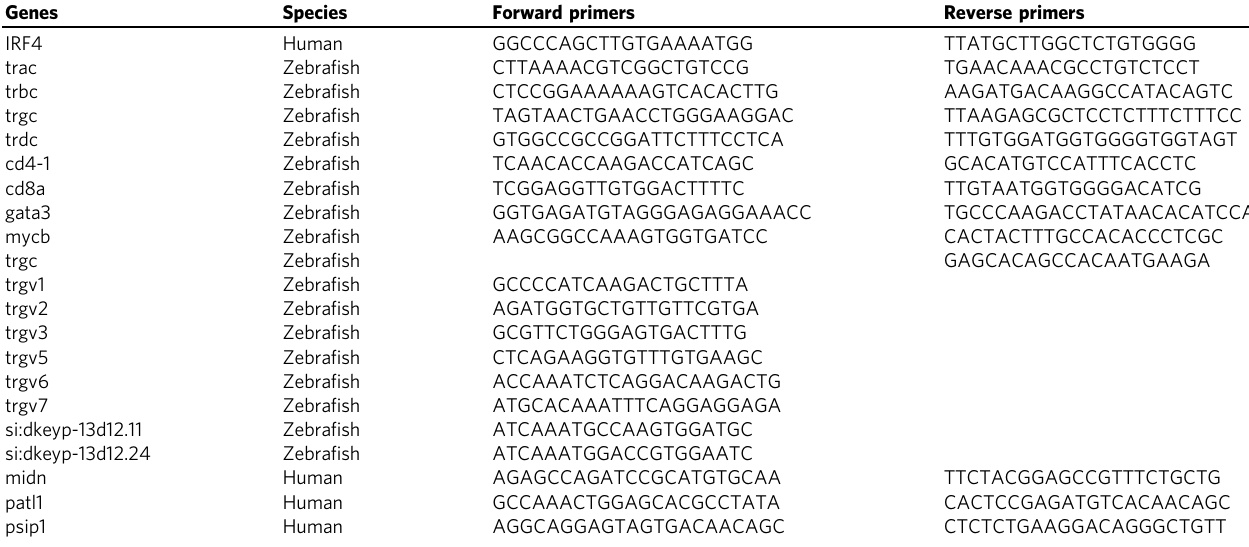
Table 2 Primers used for